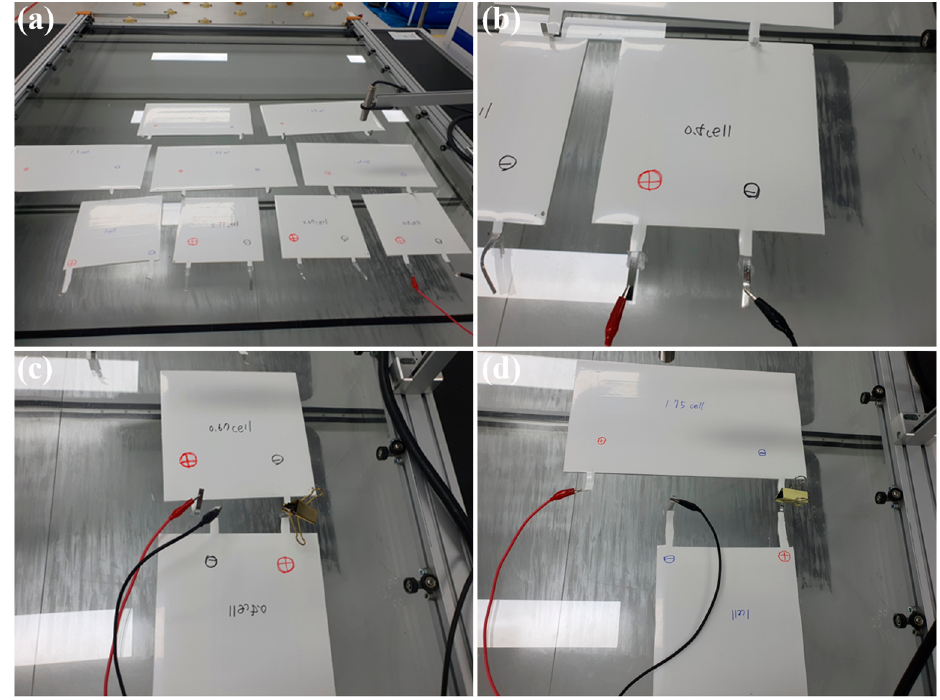
Figure 7. Simulation of individual and serial connection output from the unit